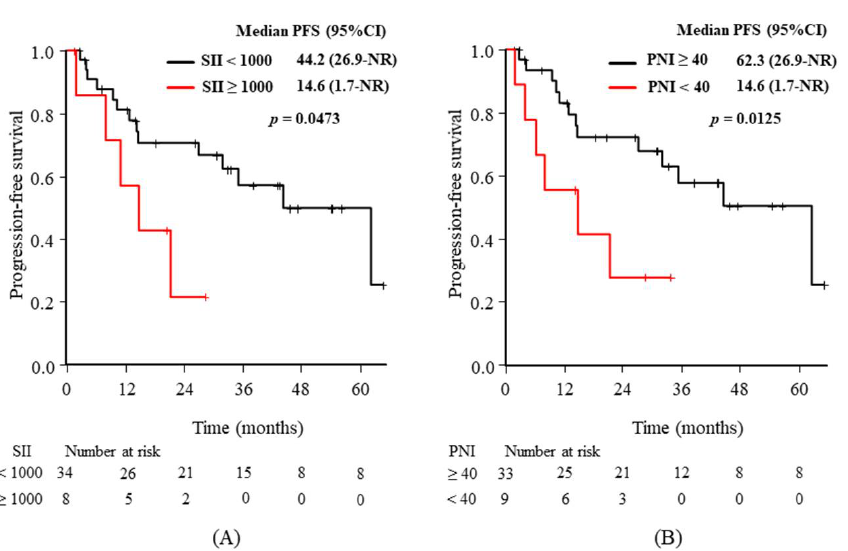
Figure 3. Kaplan–Meier curves of progression-free survival (PFS) according to the 3-week values for ( A ) systemic immune-inflammation index (SII) and ( B ) prognostic nutrition index (PNI). Longer median PFS values were associated with. an SII of <1000 and a PNI of ≥ 40 after 3 weeks of alectinib treatment. CI: confidence interval, NR: not